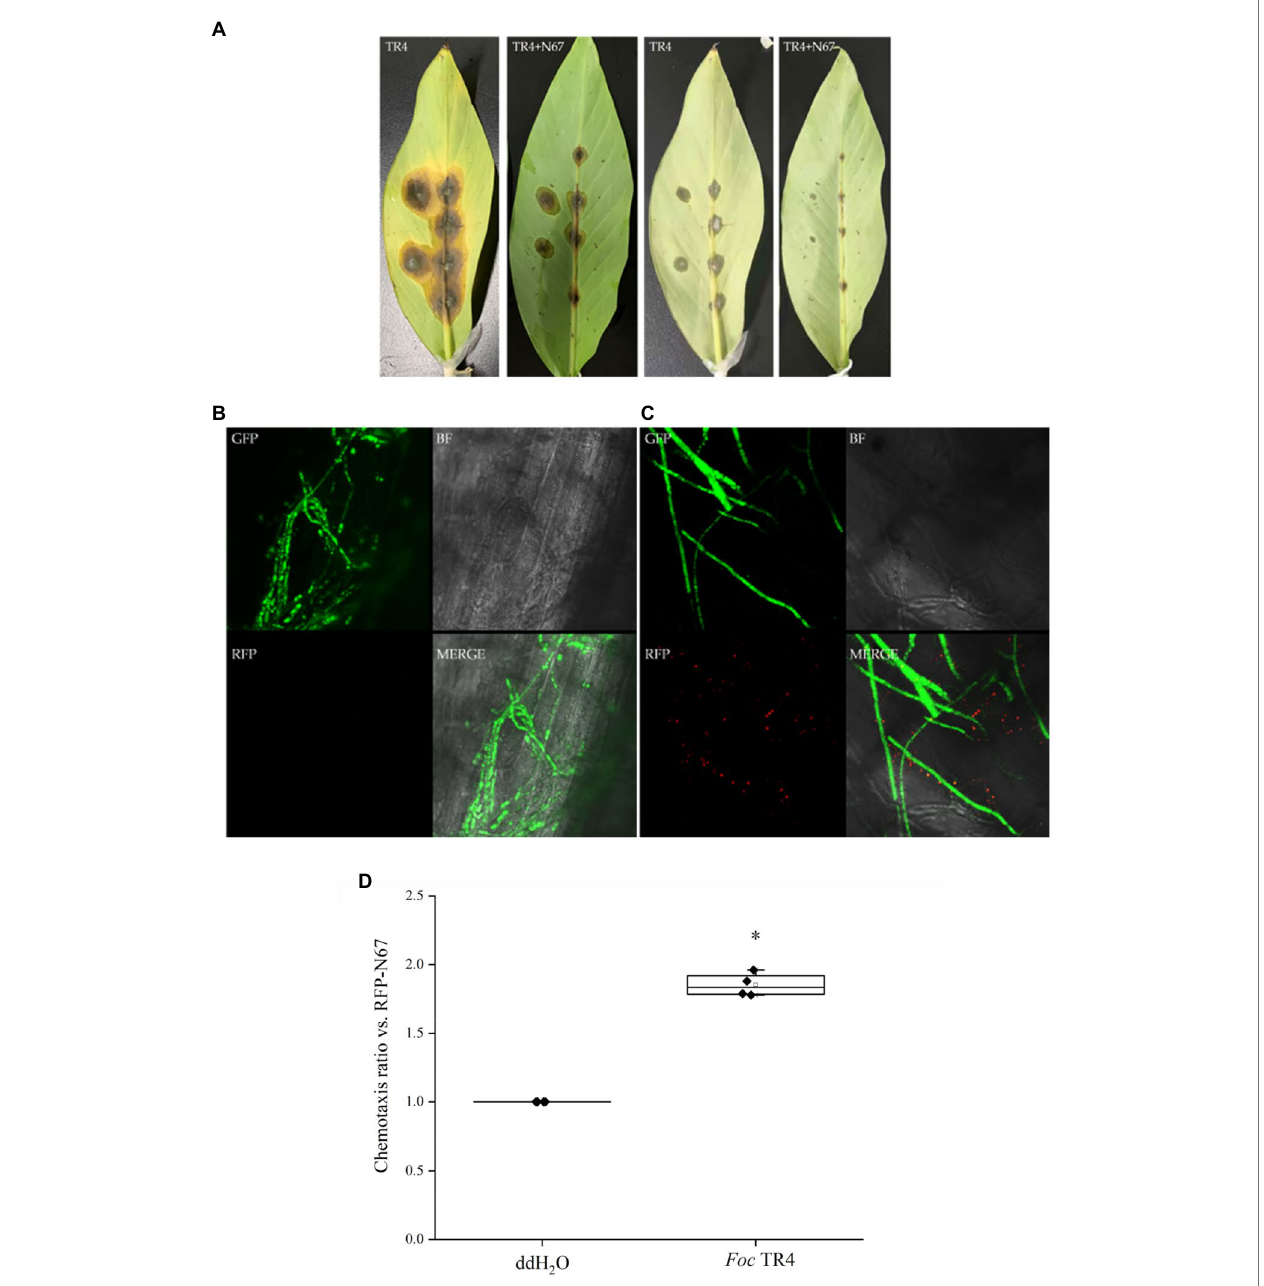
FIGURE 7 | Bacillus velezensis RFP-N67 exhibits chemotaxis toward the GFP-TR4 pathogen. N67-RFP in 9% physiological saline solution was injected into the leaf vascular bundles, and the pathogen GFP-TR4 was placed on the injection wound. (A) Disease incidence of banana leaves after 7 days’ inoculation. The first two pictures show the front side of the leaves, and the last two pictures show the back side of the leaves. Three replicates were used. (B) Microscopy of the control treatment, which injected 9% physiological saline solution with no bacteria, inoculated the GFP-TR4 only. (C) Representative micrographs of N67-RFP showed significantly chemotropic toward GFP-TR4. BF, bright field; RFP, red fluorescent field; GFP, green fluorescent field; and MERGE, merge image with BF, RFP, and GFP fields. Three replicates were used. (D) Chemotaxis ratio of RFP-N67 toward Foc TR4. * indicate the significance between treatments at the 0.05